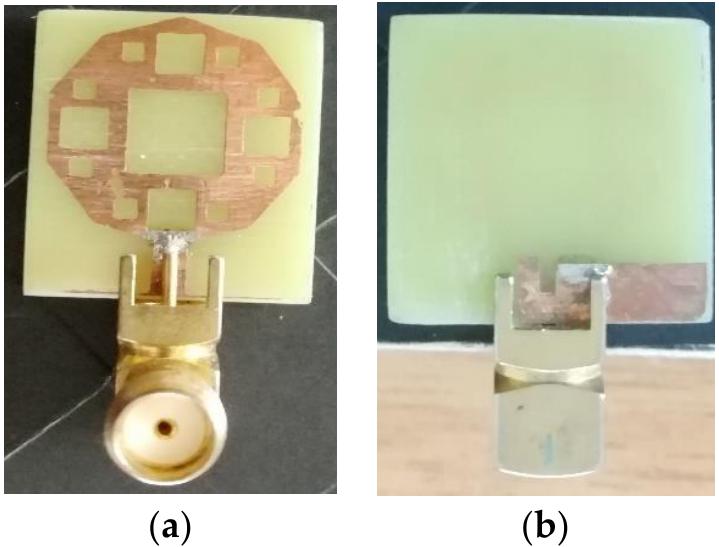
Figure 25. Proposed UWB antenna fabrication: ( a ) top portion ( b ) bottom portion.